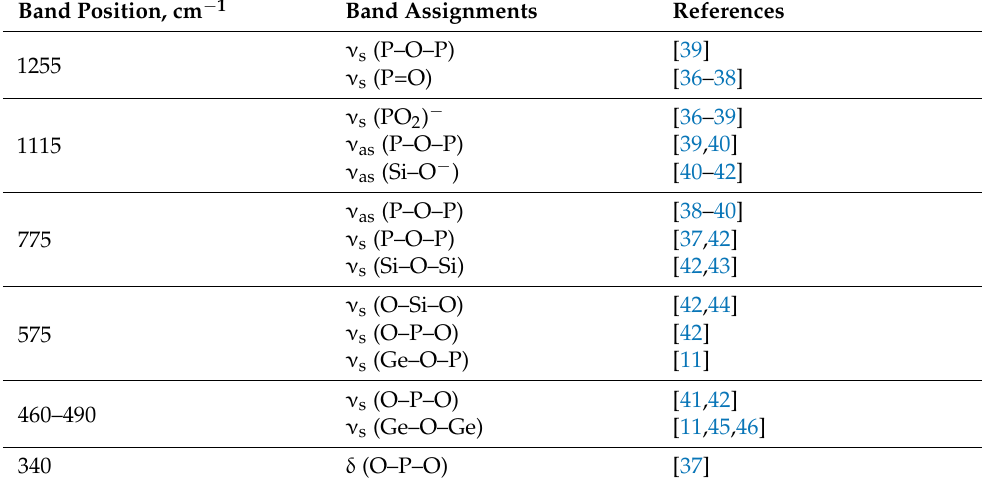
Table 3. Assignments of various vibrational bands from Raman spectra of the glasses obtained. Band Position, cm − 1 Band Assignments